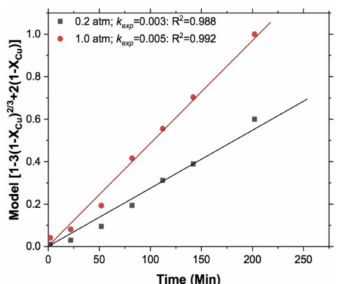
Figure 11. Copper leaching. Data treated with shrinking core model and diffusive control. Effect of pH.